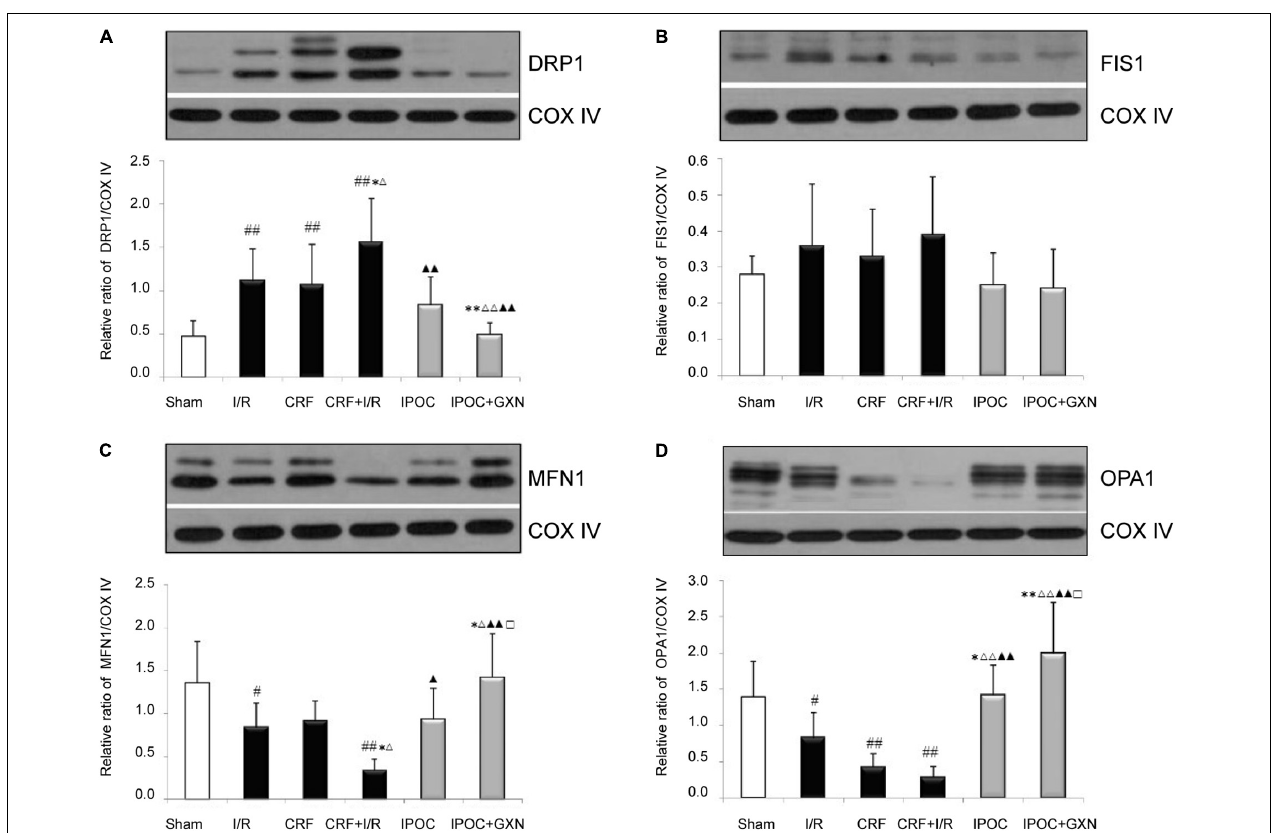
FIGURE 6 | Mitochondrial dynamics protein. (A) DRP1; (B) FIS1; (C) MFN1; (D) OPA1. Compared with SHAM group, # P < 0.05, ## P < 0.01. Compared with the I/R group, * P < 0.05, ** P < 0.01. Compared with CRF group, (cid:49) P < 0.05, (cid:49)(cid:49) P < 0.01. Compared with CRF + I/R group, (cid:78) P < 0.05, (cid:78)(cid:78) P < 0.01. Compared with IPoC group, (cid:3) P <